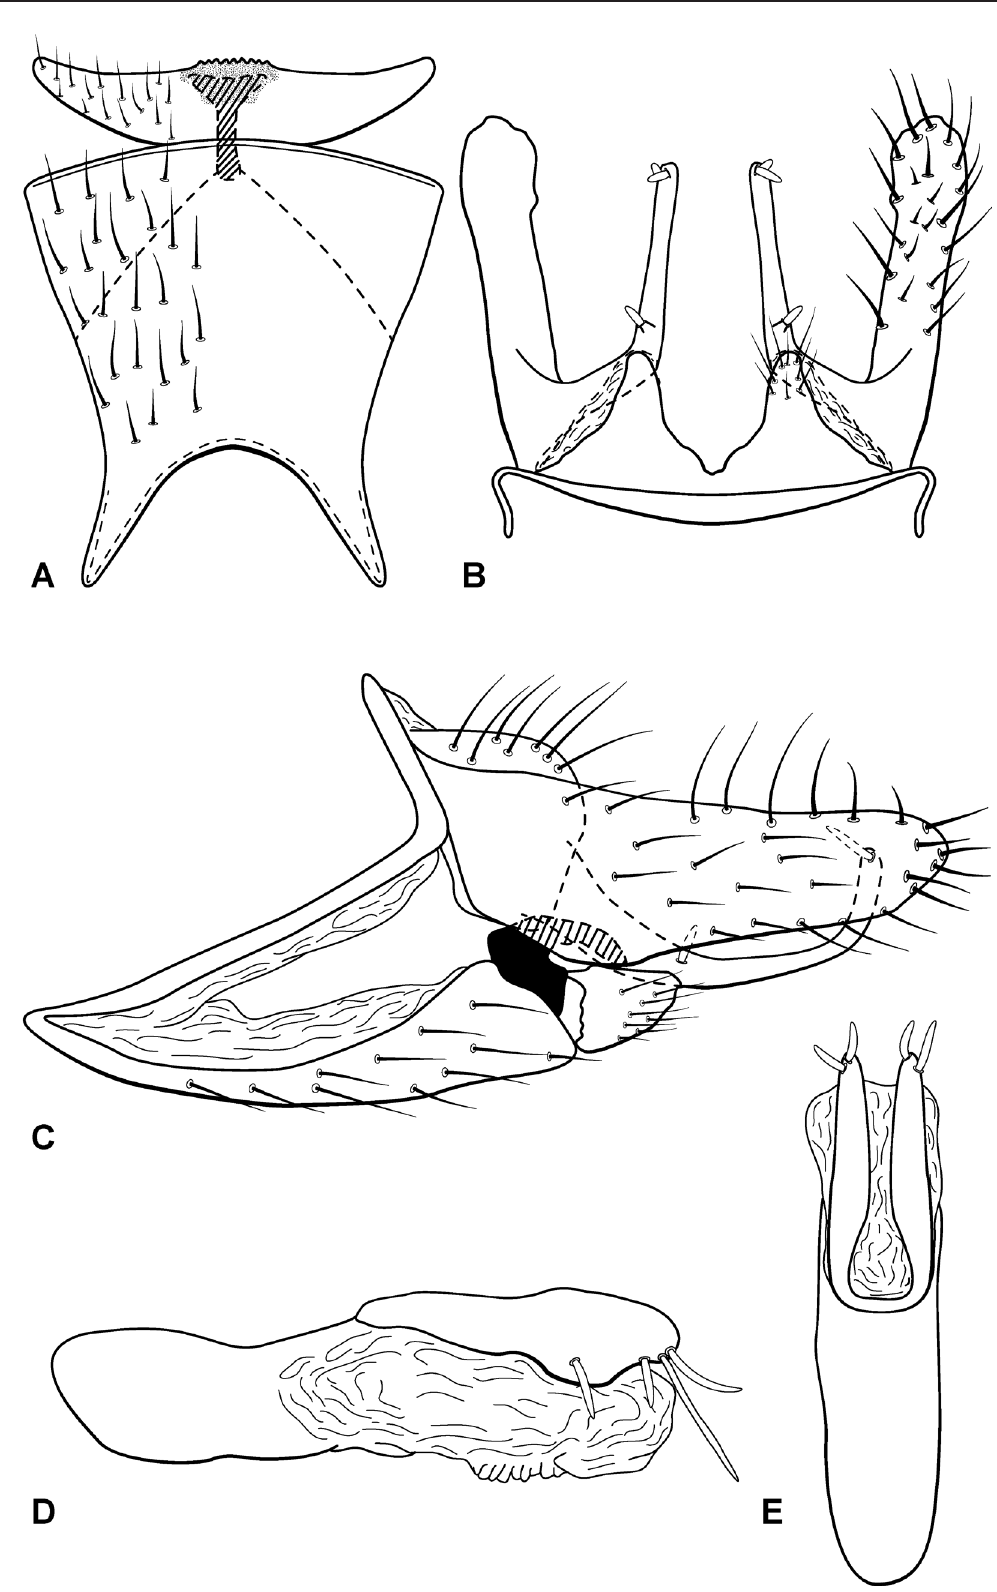
Fig. 9. Austrotinodes lattesi sp. nov., male genitalia. A . Ventral view. B . Dorsal view. C . Left lateral view. D . Phallic apparatus, left lateral view. E . Phallic apparatus, dorsal